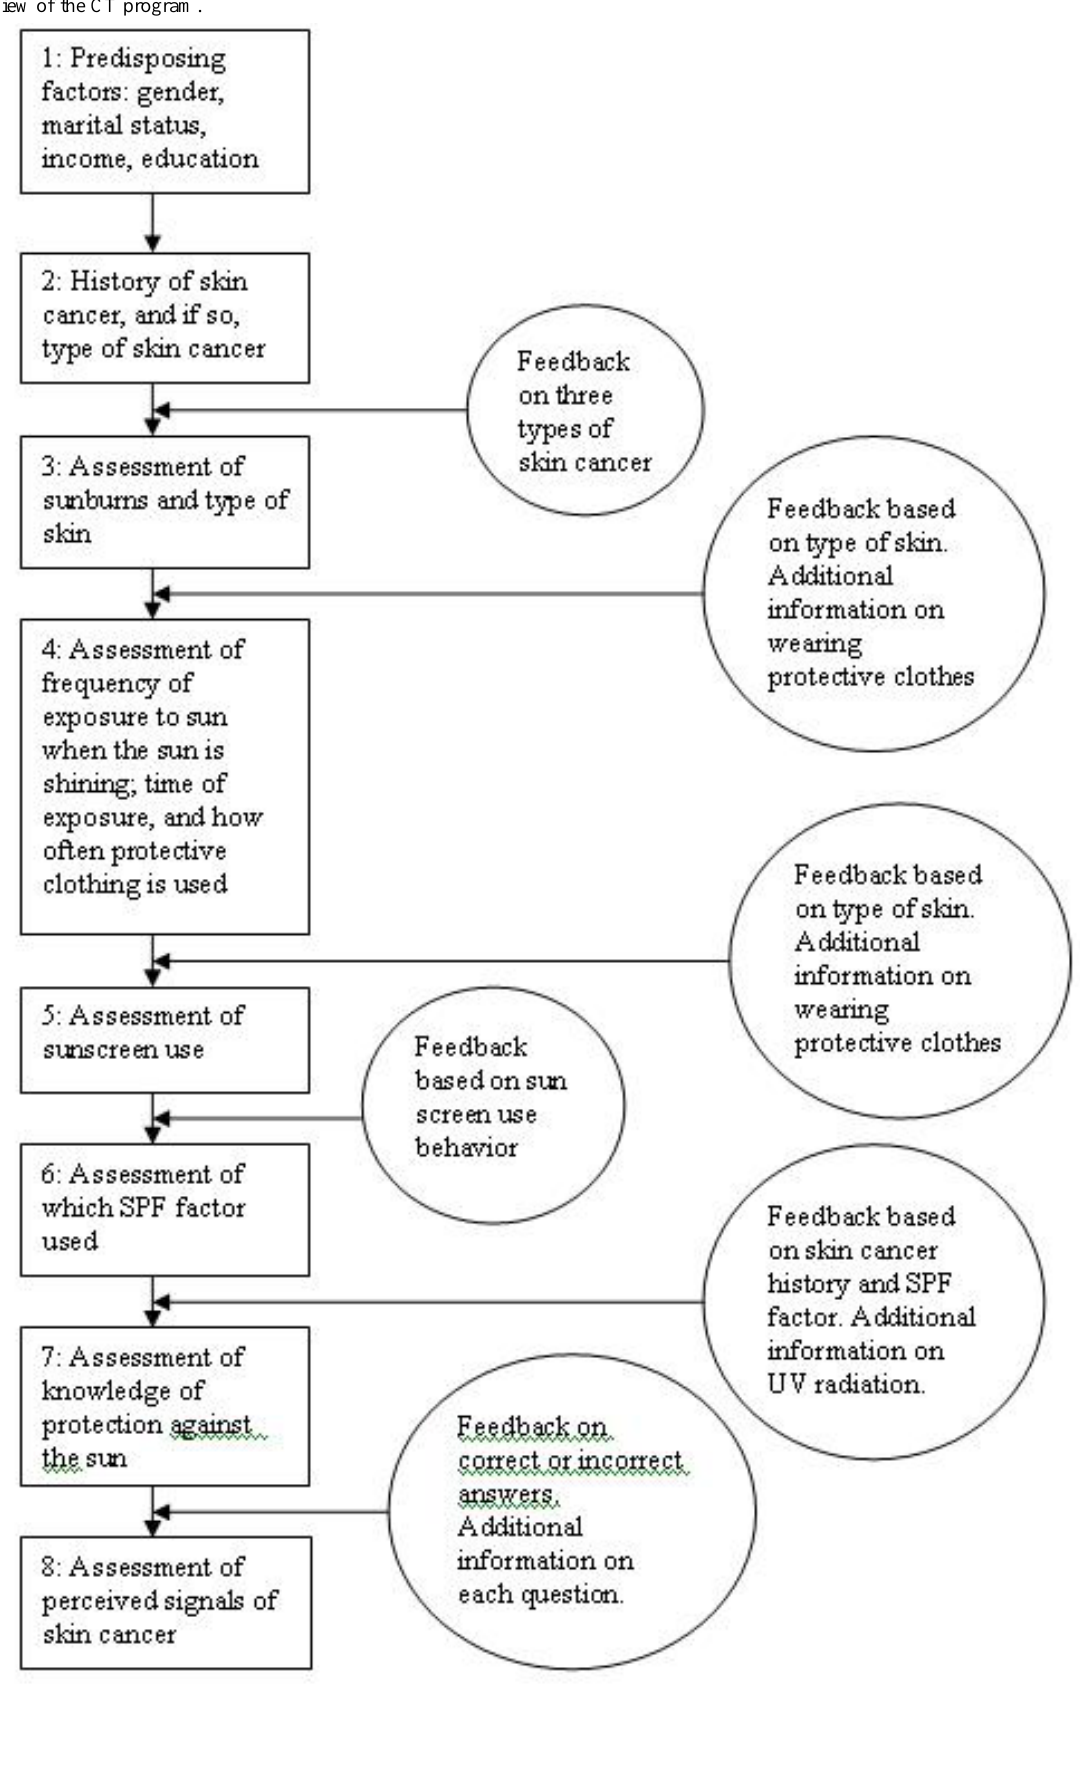
Figure 2. Overview of the CT